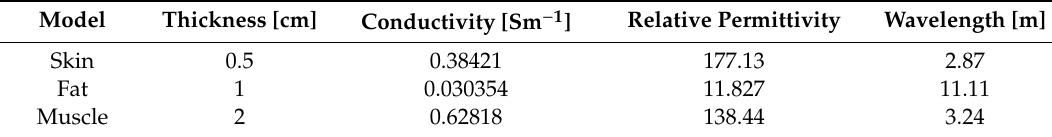
Table 1. Constitutive parameters of human biological tissue at a frequency of 13.56 MHz [17].